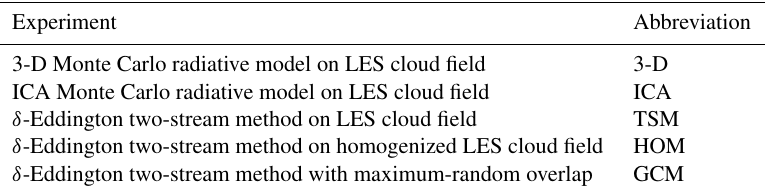
Table 1. List of preliminary radiative transfer experiments and their